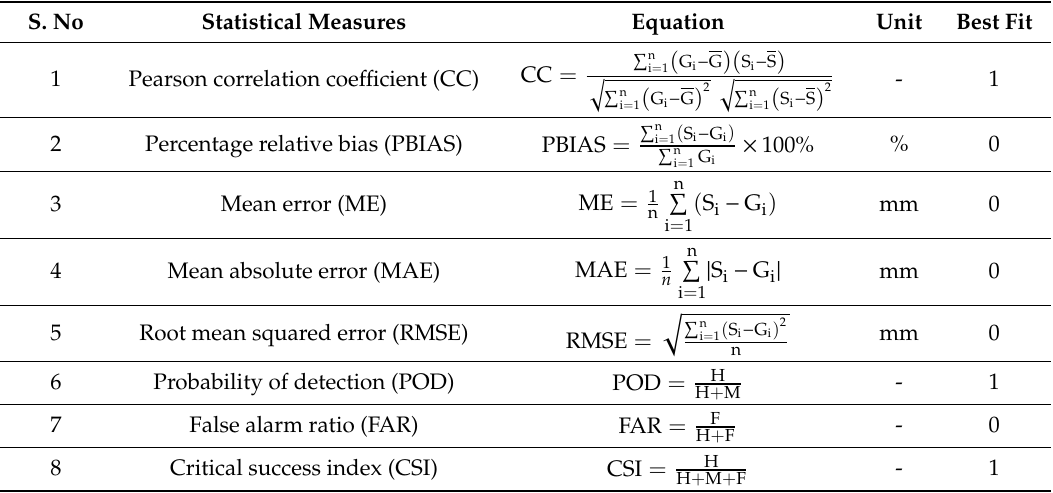
Table 1. Statistical measures used for performance evaluation of the satellite